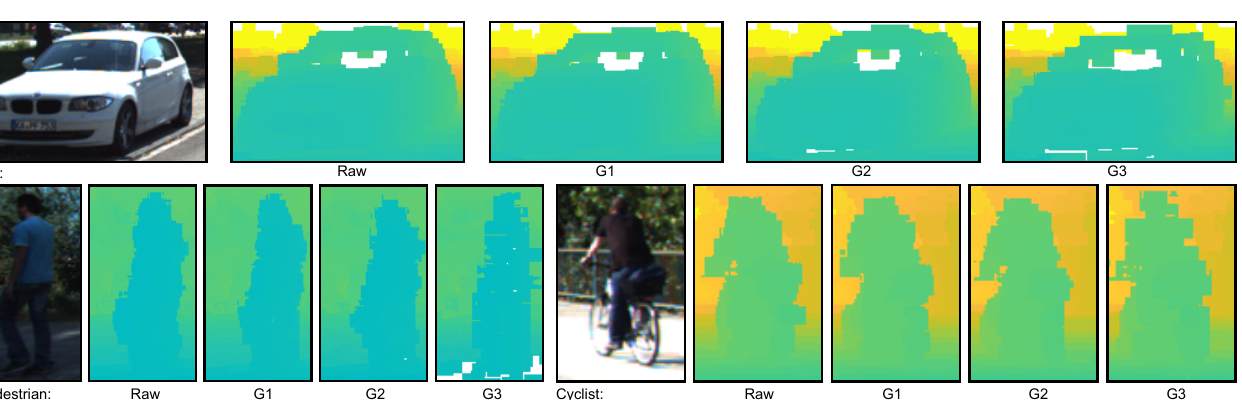
Figure 3. An example of an image from KITTI and its corresponding representations. Clockwise from top left: the RGB frame, its corresponding point cloud, the grayscale image obtained from the point cloud using a bilateral filtering method, and the grayscale image obtained from the point cloud using Delaunay triangulation.